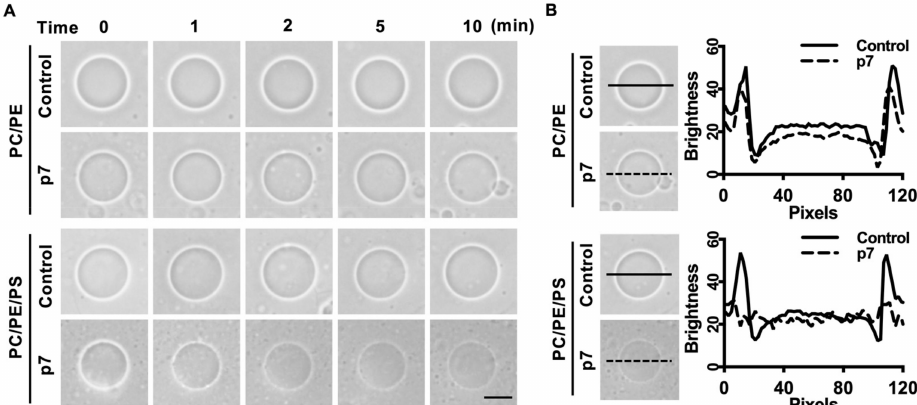
Figure 2. p7-induced giant unilamellar vesicles (GUVs) permeabilization in the presence of PS. ( A ) p7-induced GUV permeabilization. p7 was applied to GUVs composed of PC:PE, 3:1, or PC:PE:PS, 3:1:1, and incubated with external bu ff er (100 mM KCl, 100 mM sorbitol, 5 mM HEPES / Tris, pH 7). ( B ) Line profiles of p7-treated GUVs. The lines represent cross-sections of the GUVs. Data were analyzed using Zen 2 software. The scales bar indicates 10 µ